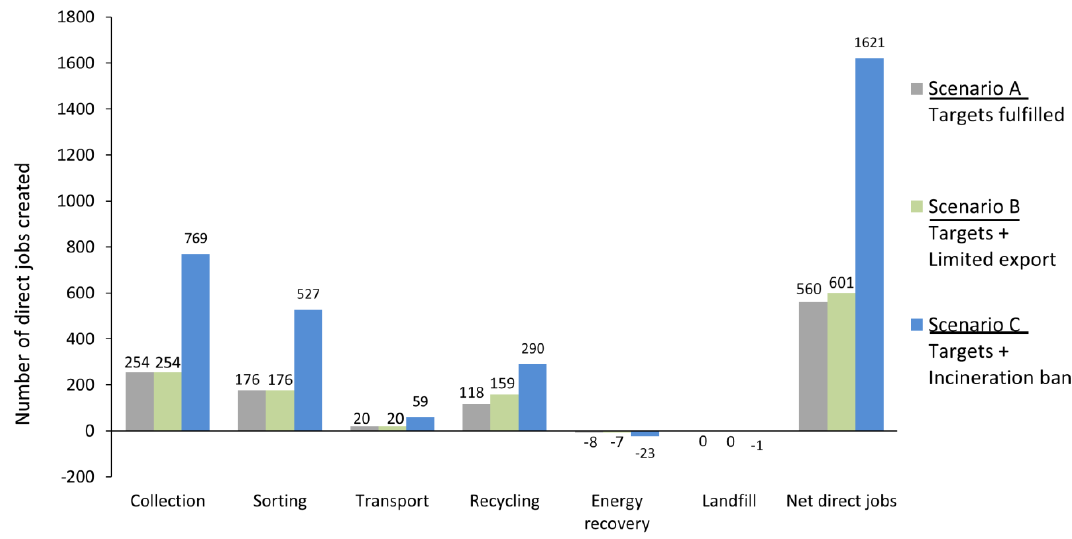
Figure 2. Number of direct jobs created (or lost) at each waste